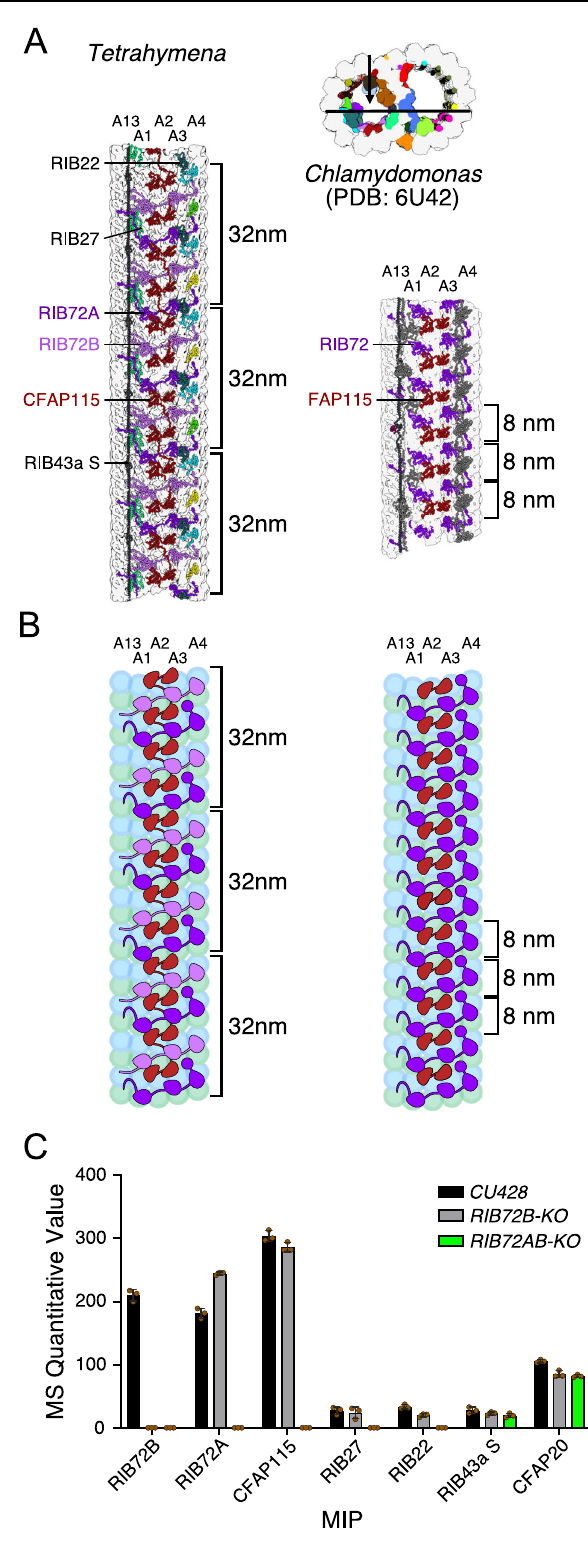
Fig.3|MIPsin Tetrahymena exhibita96-nmperiodicity.A TtCFAP115shows32- nm repeats leading to the true 96-nm periodicity of the MIPs of Tetrahymena . The FAP115 in Chlamydomonas only repeats with 8-nm periodicity, leading to the nor- mal 48-nm repeat. B The cartoon of Tetrahymena and Chlamydomonas PFs A13-A4 showing the arrangement of FAP115 and RIB72. C Quantitative value of mass spectrometry (normal total spectra value) of WT, RIB72B-KO and RIB72A/B-KO cilia showing that TtCFAP115 is still intact after the knockout of RIB72B . n =3 biological replicatesforWTandeachmutant.Dataarepresentedasmeanvalues+/ − standard deviation. Values for each replicate are shown in brown circles. Source data are provided as a Source data fi